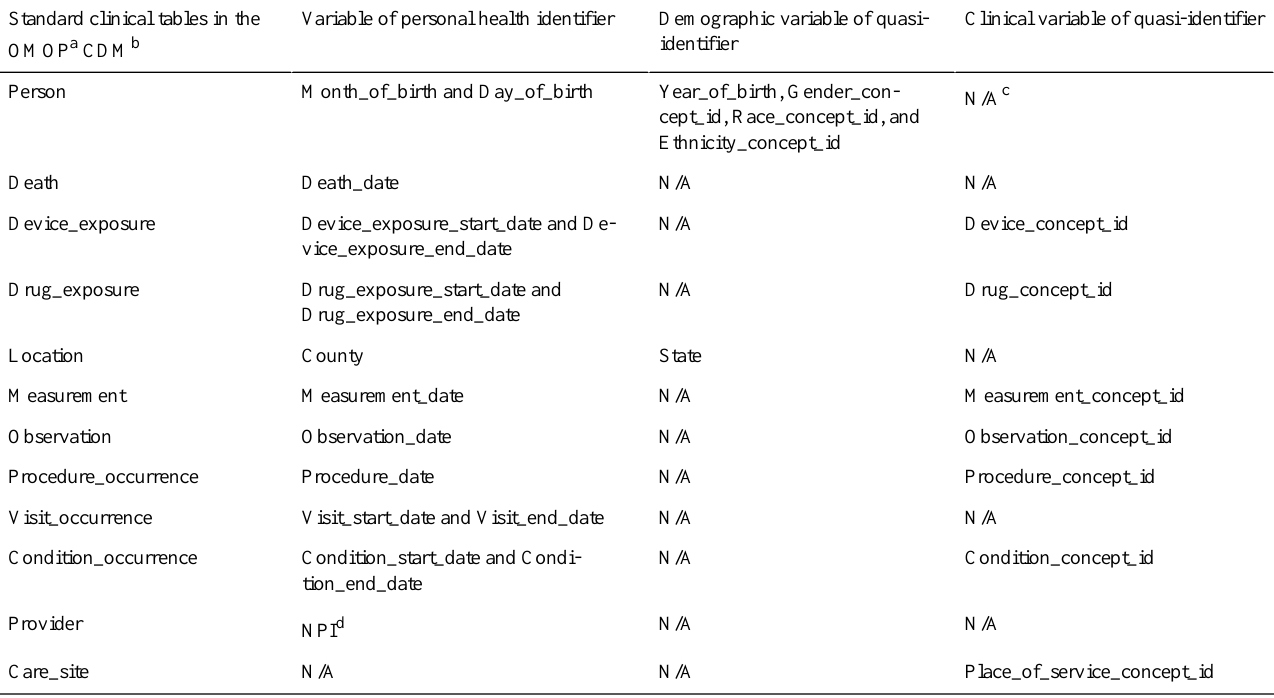
Table 1. Sixteen personal health identifiers and 12 quasi-identifiers targeted in the Observational Medical Outcomes Partnership common data model based on not null values in the Synthetic Public Use File 5 Percent data